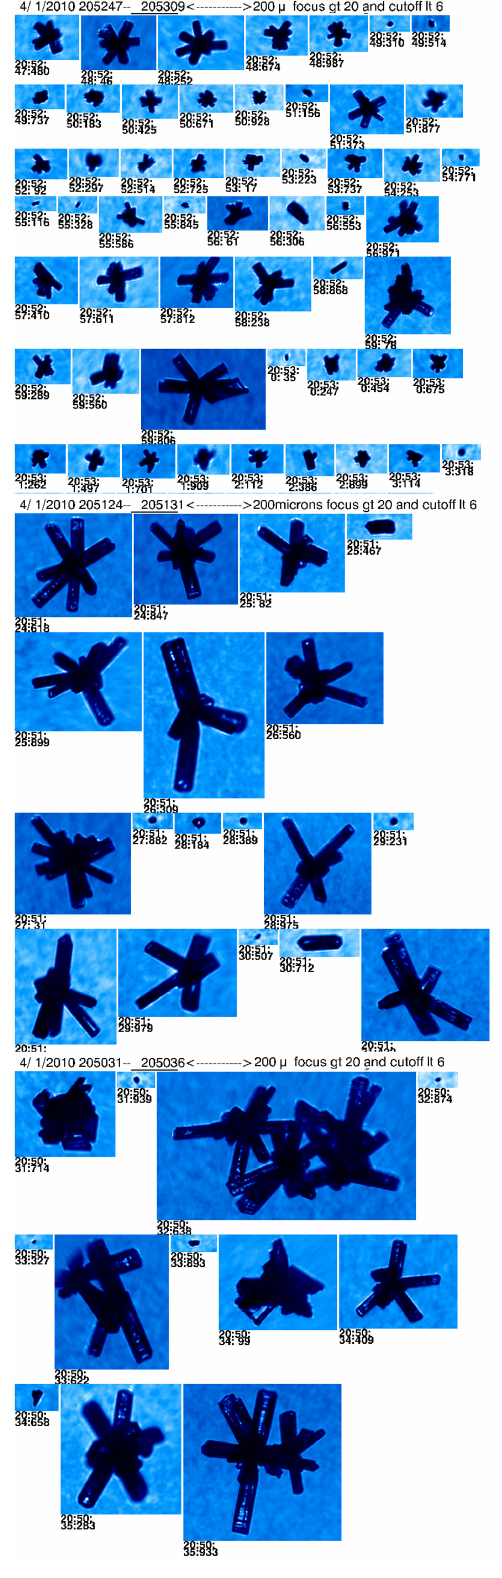
Figure 3. Bullet rosettes imaged on 1 April with D max commonly smaller than 200µm (top), larger than 200µm (middle), and aggregated